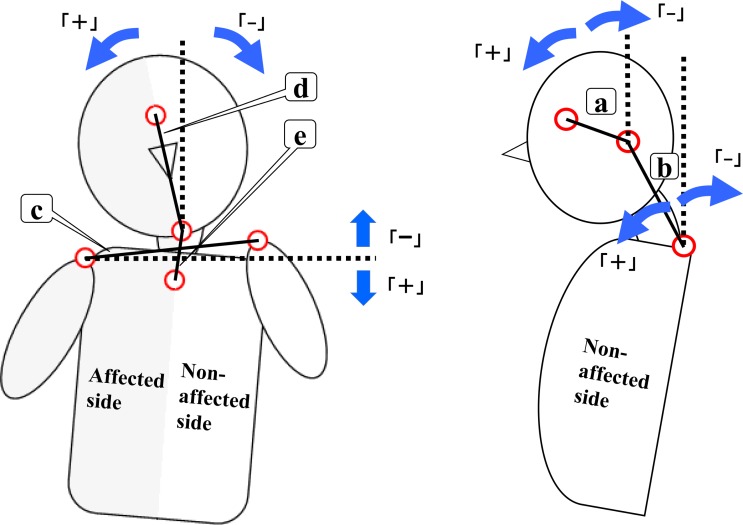
The criteria for angles and the direction of angular variation.a: Head inclination angle, between the vertical line and the line through the tragus of the ear and outer eye canthus. b: Neck inclination angle formed between the vertical line and the line through C7 and the tragus. c: Acromial tilt angle formed between the horizontal line and the line through both acromion processes. d: Head lateral inclination angle formed between the vertical line and the line through the glabella and the top of the chin. e: Neck lateral inclination angle formed between the vertical line and the line through the top of the chin and the superior margin of the sternum. The variation through the tasks was represented as postactive posture angle–preactive posture angle. This figure is an example of right hemiplegia.